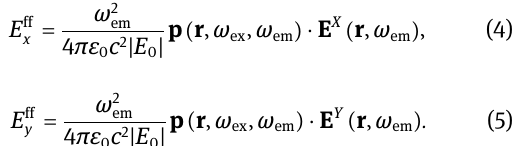
where we have introduced the enhancement factor